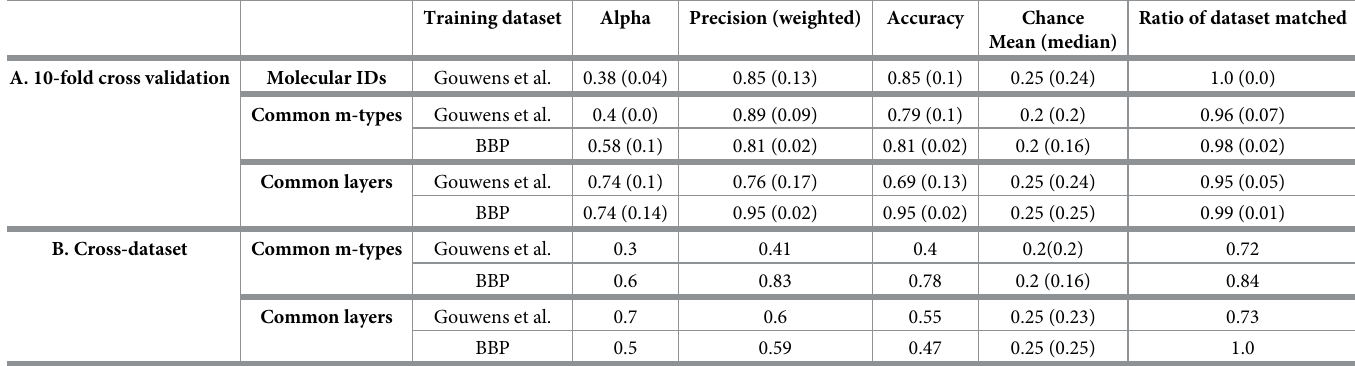
Table 1. Validation experiments results. Section A: 10-fold cross-validation on the Gouwens et al. dataset using molecular markers, common m-types and common layer labels. 10-fold cross-validation on BBP dataset using common m-types and common layer labels only. Mean (standard deviation) are shown except for the chance level column where it is mean (median). Section B: Cross dataset validation on common m-types and on common layer labels,